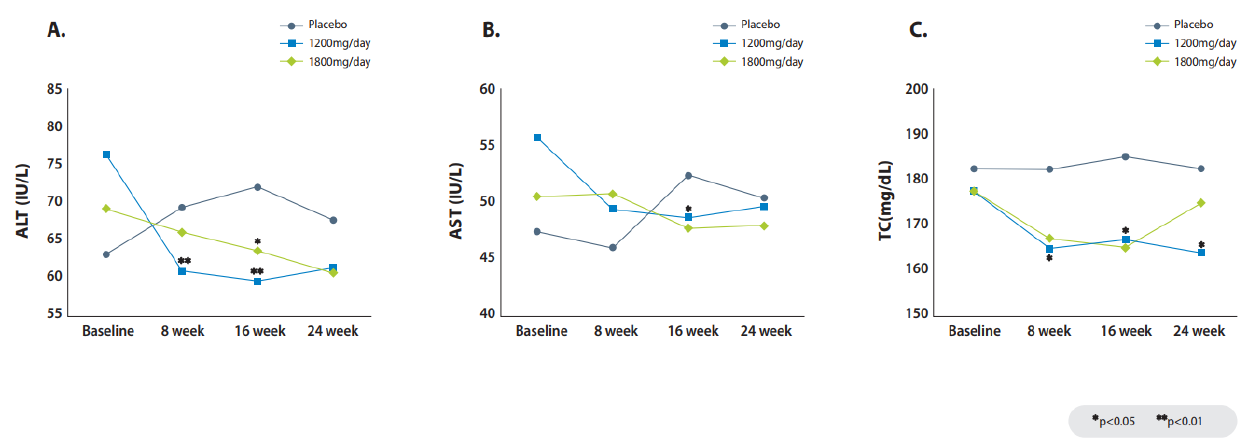
Figure 3. Change of liver biochemistry in the FAS. Time course of liver enzymes ALT ( A ), and AST ( B ). Time course of total cholesterol level ( C ).